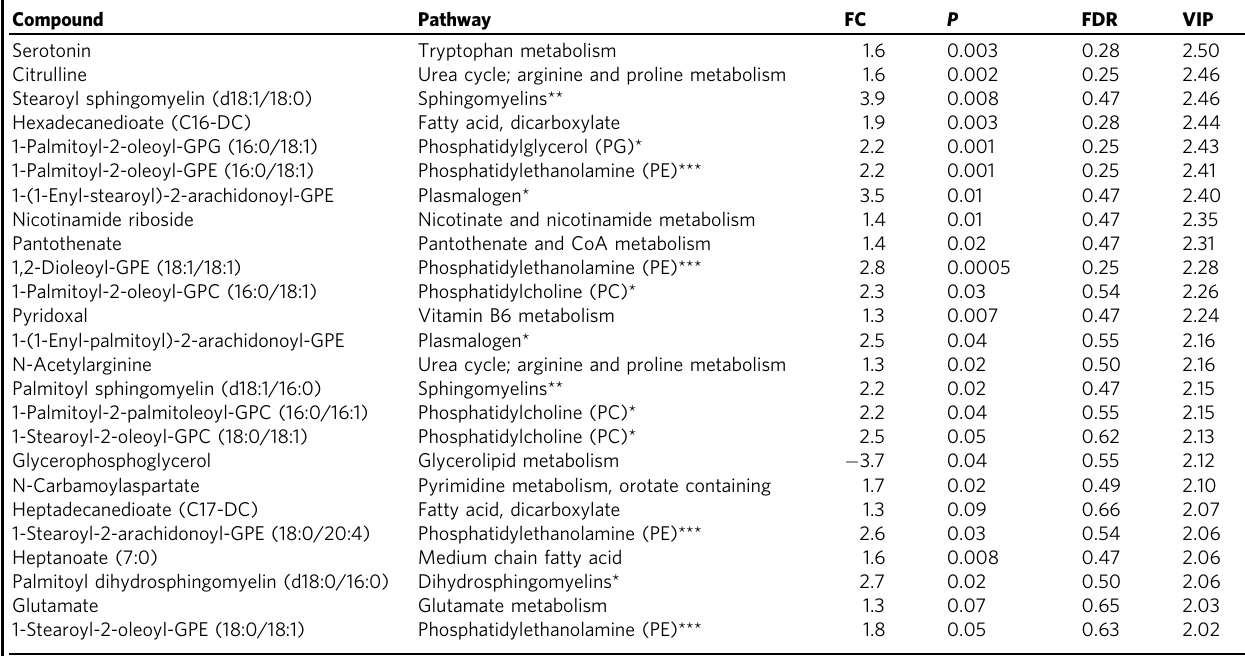
Table 3 Caecum metabolomics of host – gut microbiota interactions in rats exposed to a pesticide mixture reveals alterations in multiple metabolic